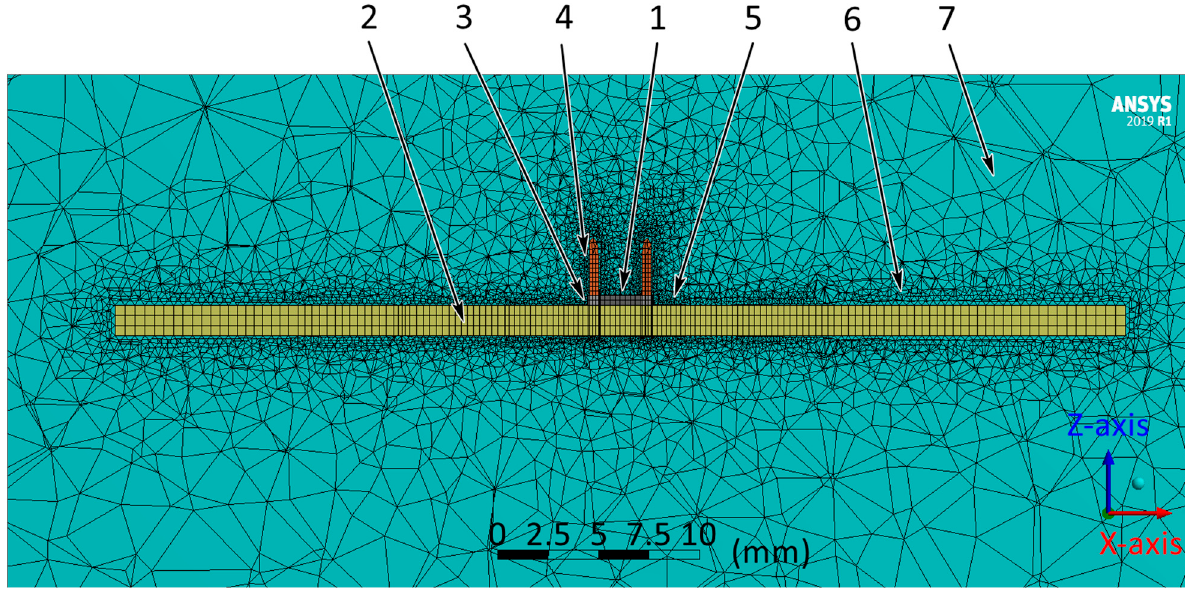
Figure 4. Cross-section of the final view of the geometric model: 1—component; 2—base; 3—solder; 4—wire; 5—cylinder.